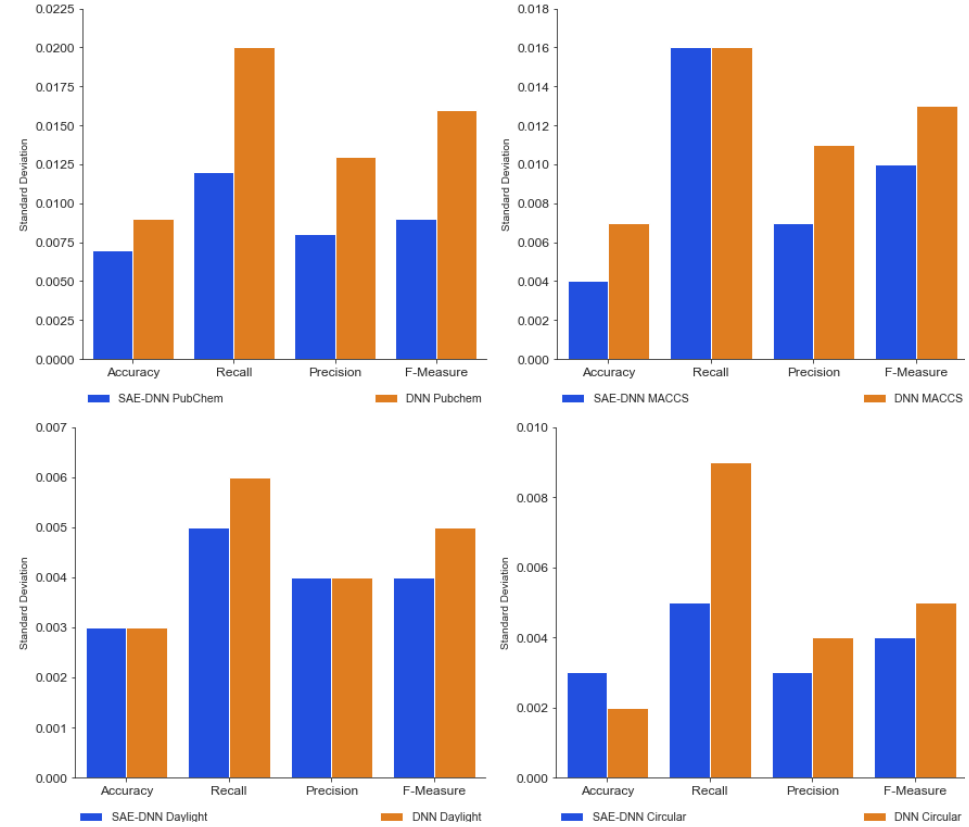
Figure 6. Standard deviation for all metrics in SAE-DNN and DNN without pre-training results. In general, SAE-DNN produced a lower standard deviation for all metrics compared to DNN without pre-training. A lower standard deviation value indicates that the model’s performance is more stable for each fold in the cross-validation process. These results imply that the SAE-DNN model has better generalization power than the DNN without pre-training.